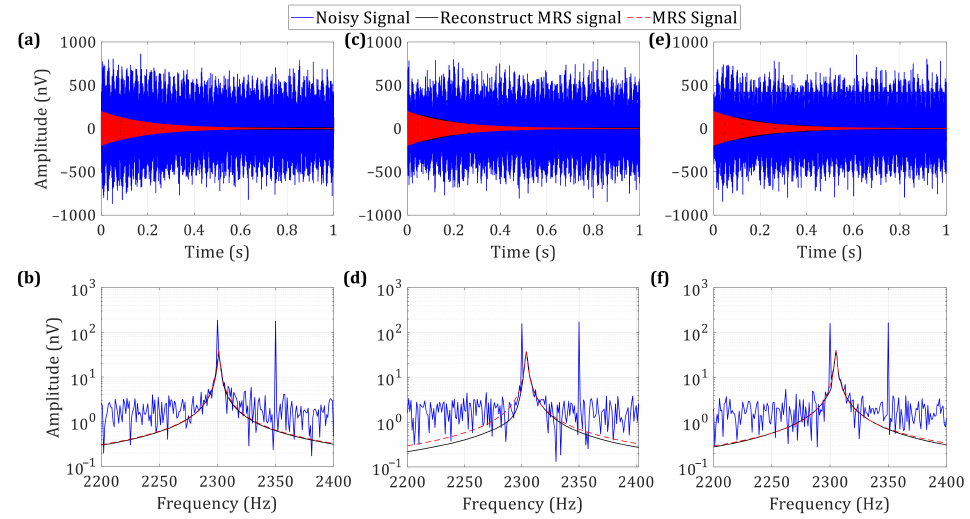
Figure 3. Comparison of denoising results under different f l : ( a ) ∆ f = 1 Hz, ( b ) is the corresponding spectrum; ( c ) ∆ f = 3 Hz, ( d ) is the corresponding spectrum; ( e ) ∆ f = 5 Hz, ( f ) is the corresponding spectrum.